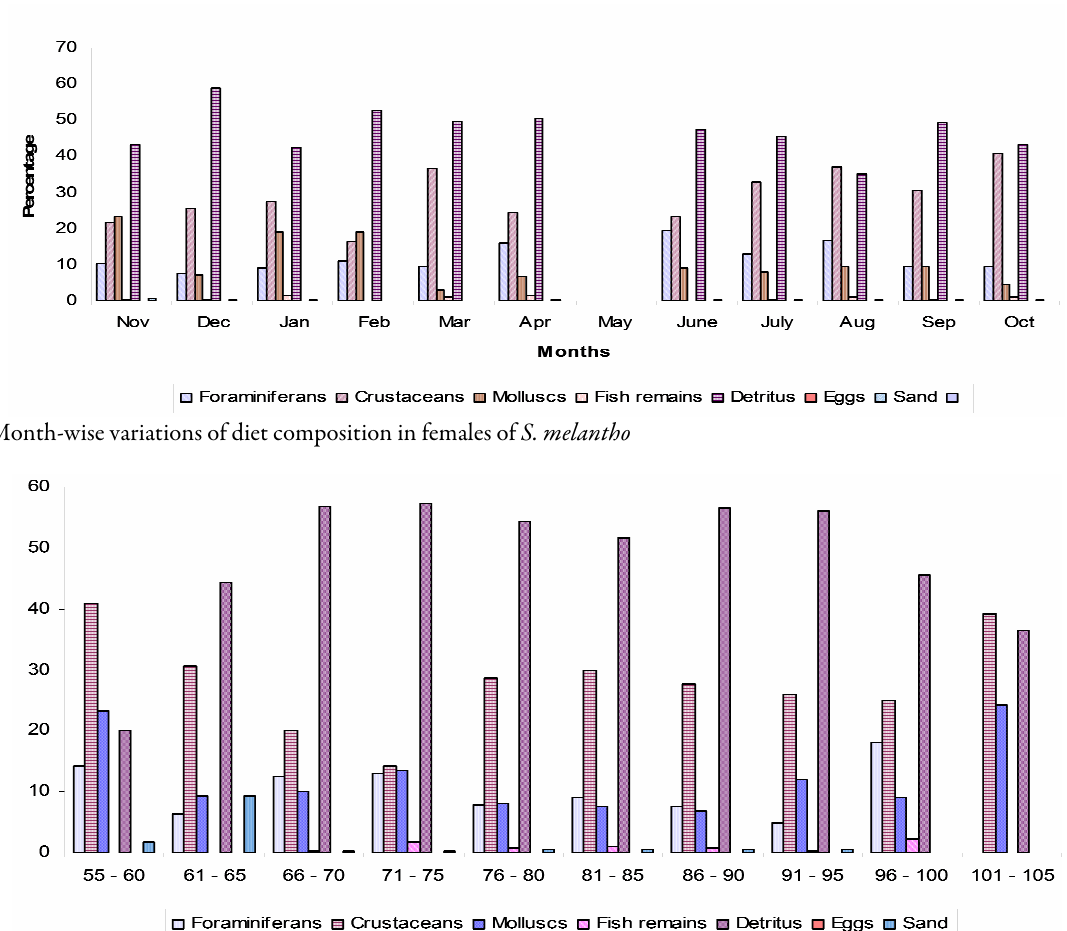
Fig. 3. Month-wise variations of diet composition in males of S . melantho